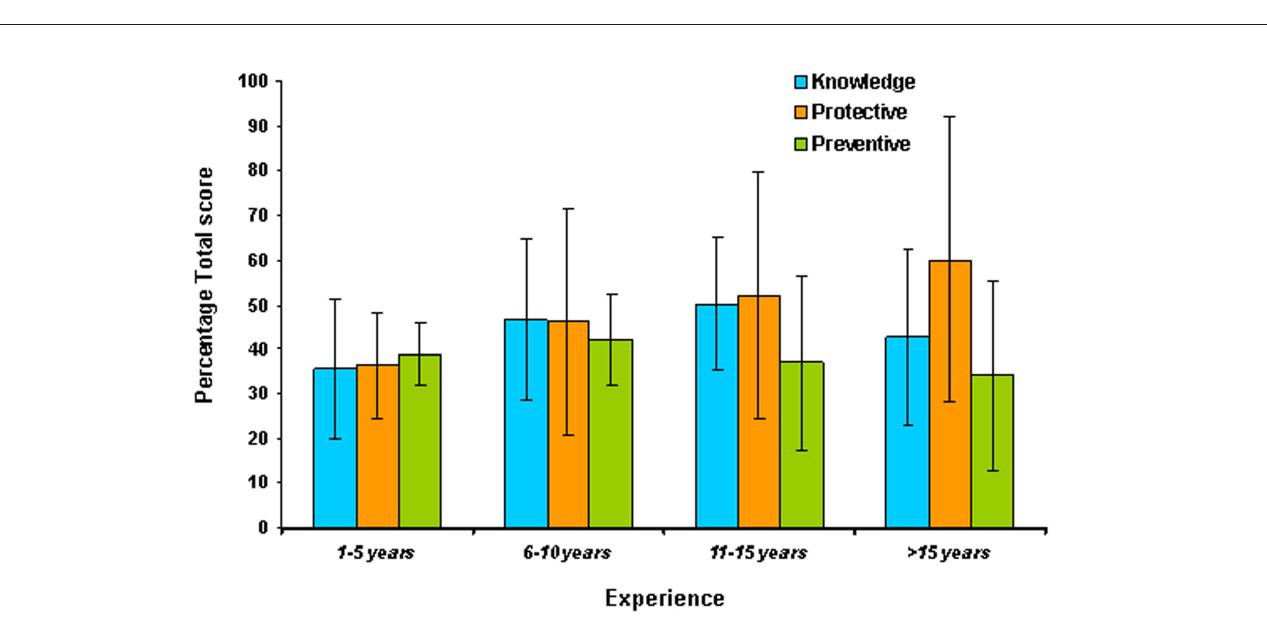
Fig. 2. Knowledge and protective and preventive measures varying with the years of clinical experience.